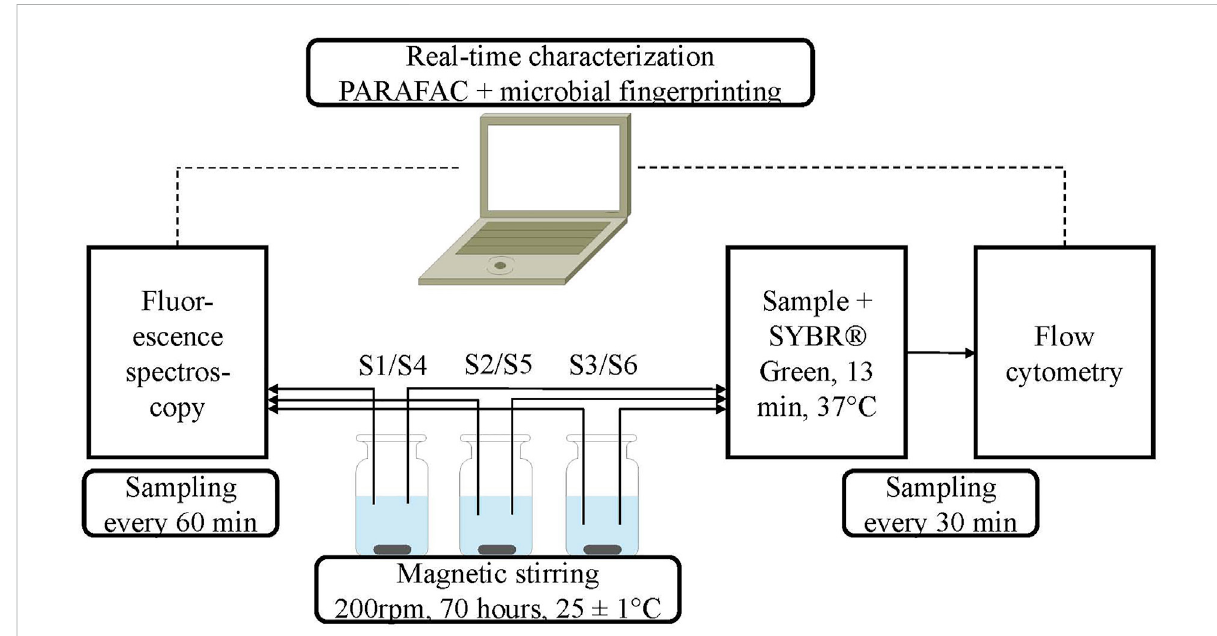
FIGURE 1 Flow scheme of the real-time characterization setup via fl uorescence spectroscopy and fl ow cytometry, which enables the simultaneous analysis of three different